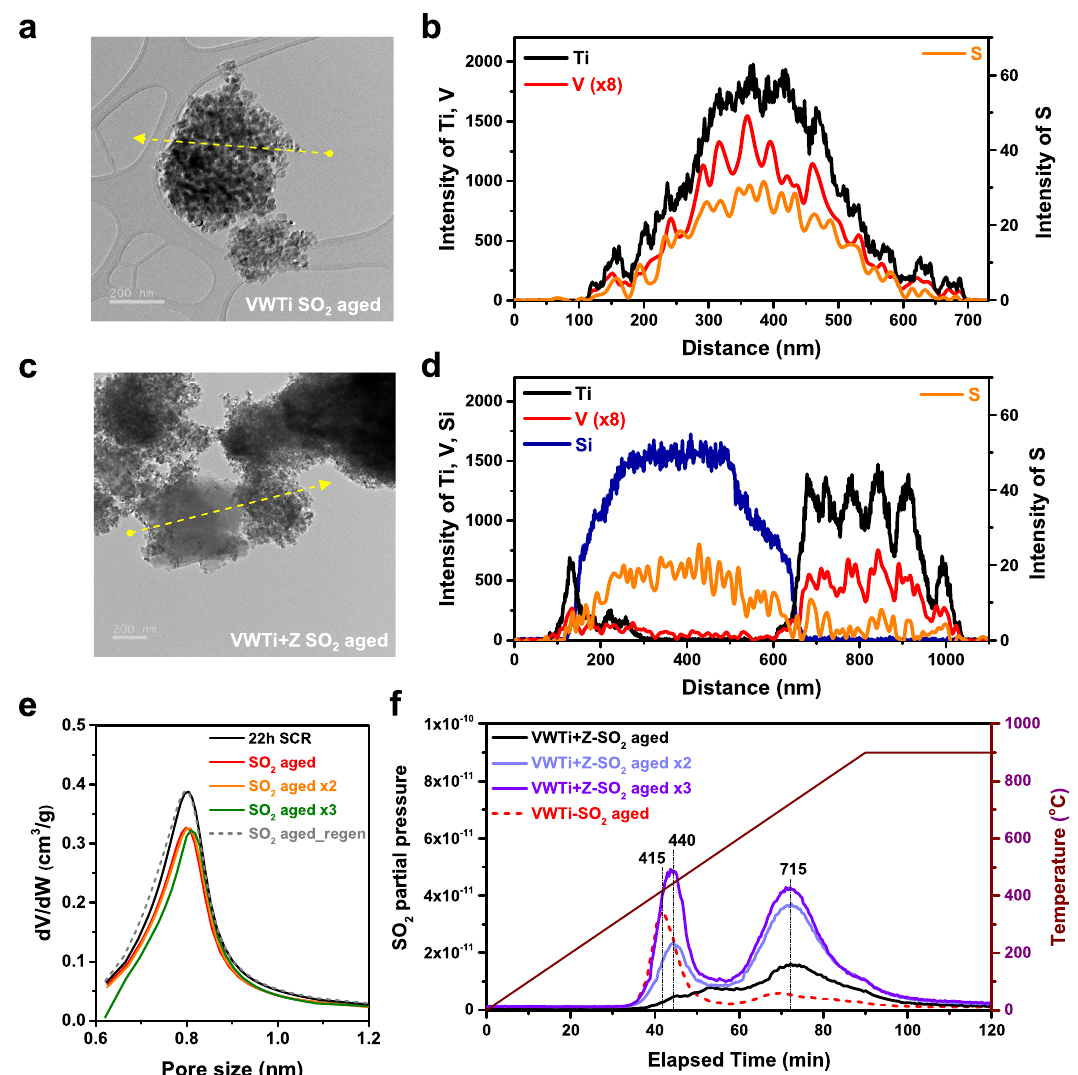
Fig. 2 Location and species of sulfur after SO 2 aging. a , b TEM image and line-EDS of the SO 2 aged VWTi. c , d TEM image and line-EDS of the SO 2 aged VWTi + Z. In the segregated region of the VWTi (Ti, black) and Y zeolite (Si, navy), a distribution of sulfur (orange) could be investigated. e Micropore distribution of the VWTi + Z fresh, SO 2 -aged and regenerated catalysts from the Ar adsorption results. To eliminate the effect of the structure degradation under SCR conditions at 220 °C, VWTi + Z treatment under a NH 3 -SCR reaction for 22 h (black) was suggested as a standard. f Thermal decomposition pro fi les of sulfur species on the SO 2 -aged VWTi + Z and VWTi catalysts. Decomposed sulfur species were measured by using mass spectrometry, and any other sulfur species was not detected except SO 2 . A low temperature peak at ~400 °C is assigned to SO 2 from the decomposition of ABS, and high temperature peak at ~700 °C is SO 2 from a decomposition of metal